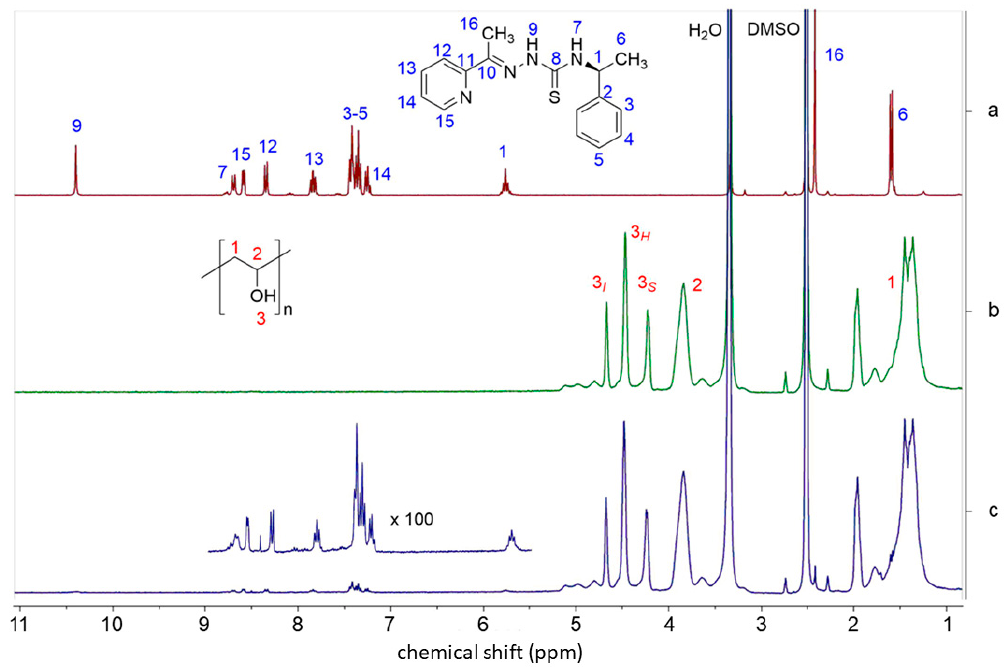
Figure 4. 300 MHz 1 H NMR spectra of ( a ) HapyTSCmB, ( b ) PVA, and ( c ) PVA / TSC10-PVA fibers in dimethyl sulfoxide (DMSO- d 6 ) solution.